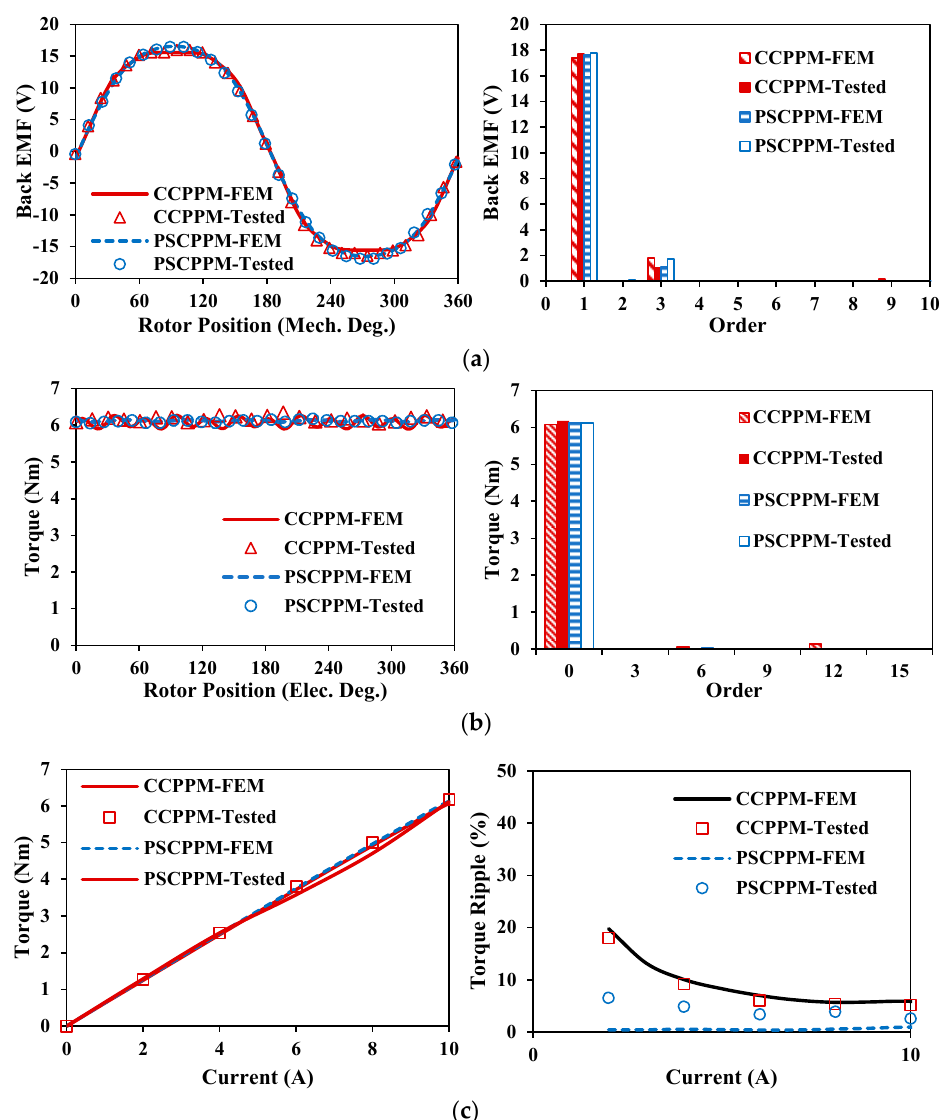
Figure 43. On load performances of 12s8p machines. ( a ) Back EMFs. ( b ) Rated torques (10A). ( c ) Torque performances under different current.